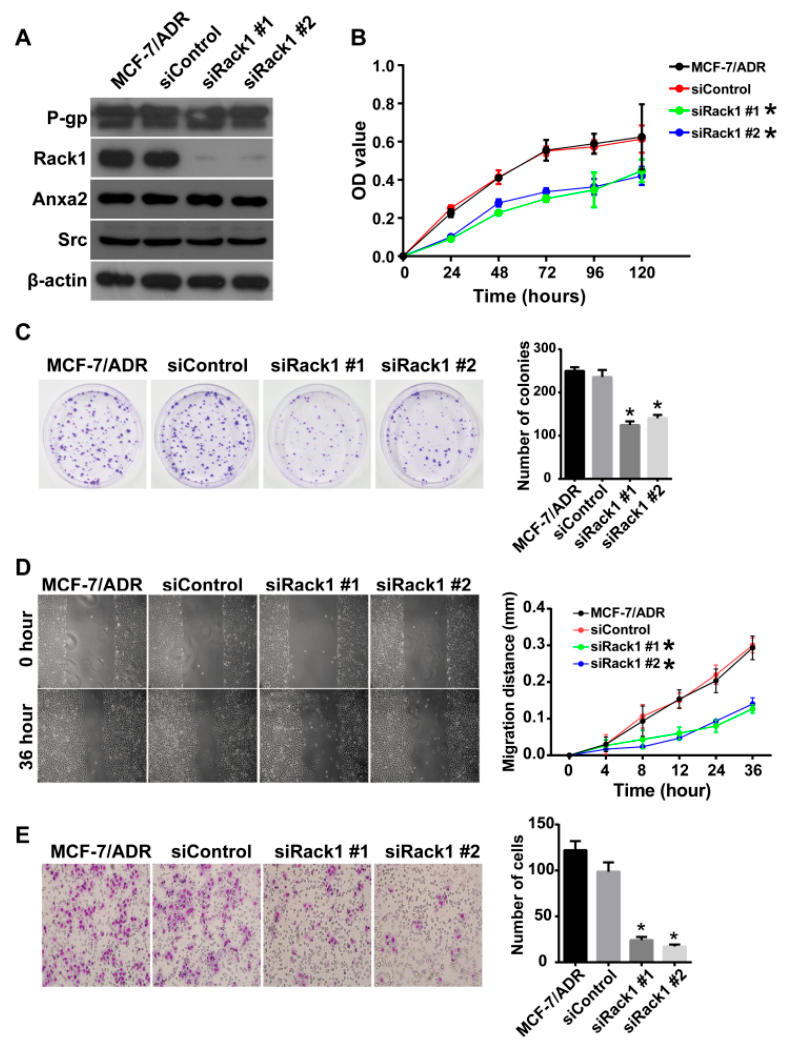
Figure 3. Knockdown of Rack1 inhibits the proliferation, migration and invasiveness of multidrug-resistant breast cancer cells. ( A ) Western blotting analysis of P-gp, Rack1, c-Src and Anxa2 expression in MCF-7/ADR cells transfected with control or Rack1 specific stealth siRNAs (# represents siRNA sequence ); ( B ) Silencing of Rack1 expression inhibited cell proliferation compared with that of control cells. Wild type, control and Rack1 knockdown cells were seeded in 96-well plates at a density of 4 × 10 3 cells per well and consecutively cultured for 24, 48, 72, 96 and 120 h. The cell proliferative activity was calculated using the CCK-8-based method by measuring the absorbance at 450 nm on a micro-ELISA reader. The assays were carried out using six replicates for each time point and repeated three times; ( C ) Knockdown of Rack1 induced a significant decrease in the colony formation ability of breast cancer cells. Control and Rack1 knockdown cells were seeded in 35-mm dishes at a density of 500 cells per dish and cultured for 10 days. The number of colonies was quantified under an inverted microscope; ( D ) Knockdown of Rack1 significantly inhibited cell migration as measured by the wound healing assay (100 × magnification). Relative cell migration distance was quantified and plotted in the right panel. Data as the mean ± SD of triplicates, p < 0.0001; ( E ) Knockdown of Rack1 expression inhibited the invasion ability of breast cancer cells (200 × magnification). Approximately 200 µ L of cell suspension (approximately 8 × 10 4 cells) in serum-free medium were added to the upper transwell inserts pre-coated with Matrigel; the lower insert was loaded with 10% FBS-containing cell culture medium. After 36 h of incubation at 37 ◦ C, invaded cells were fixed, stained and counted under an inverted microscope. The average result of triplicate experiments is summarized in the right panel. Data as the mean ± SD, p < 0.0001 versus control cells. Statistical analysis was performed by one-way ANOVA (* p < 0.05).